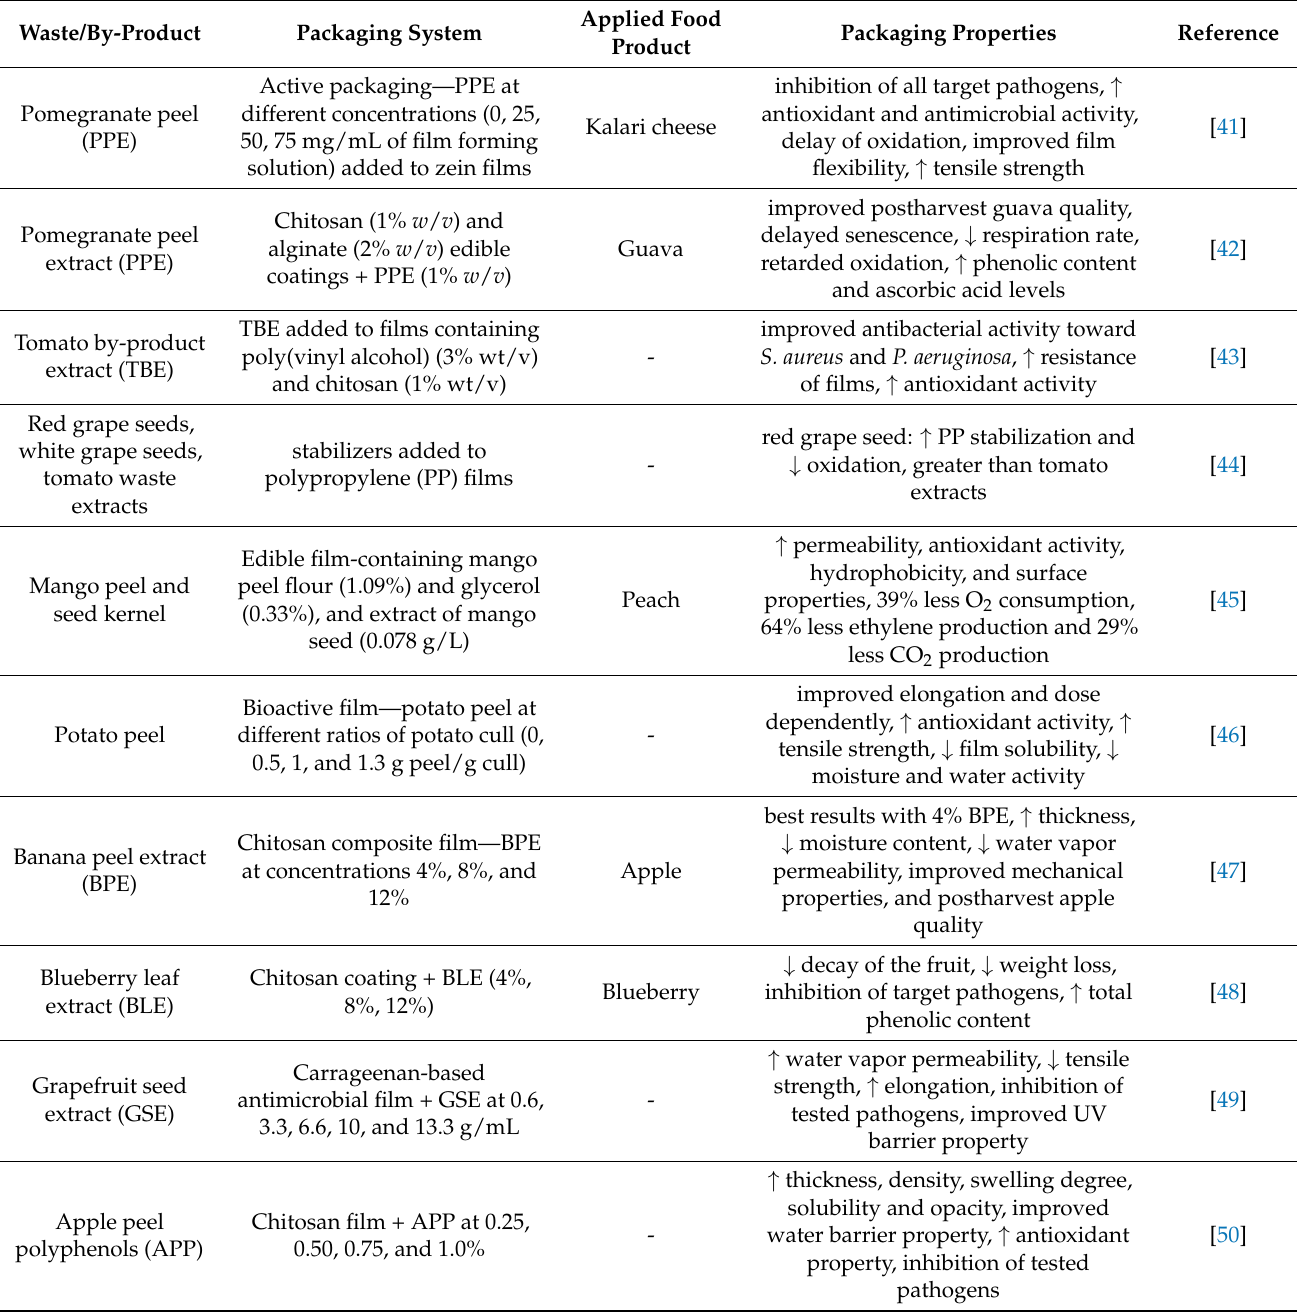
Table 1. Application of fruit and vegetable wastes and by-products in food packaging